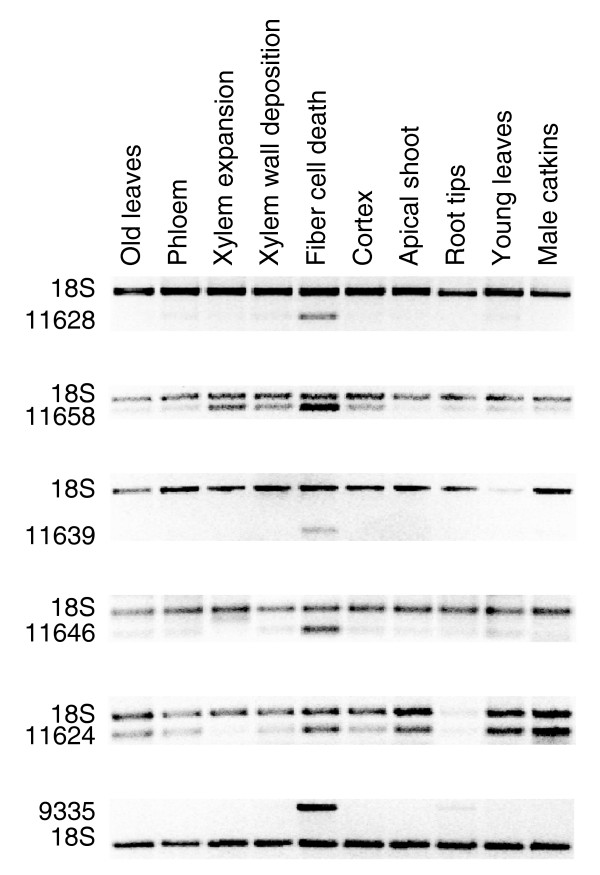
RT-PCR analysis of gene expression in different parts of a Populus tree. Expression of glycosyl hydrolase family 1 protein (POPLAR.11628), proline-rich protein (POPLAR.11658), oligopeptide transporter (POPLAR.11639), an expressed protein (POPLAR.11646), an F-box protein (POPLAR.11624) and a protease inhibitor/seed storage/lipid transfer protein (POPLAR.9335) is shown in relation to 18S DNA expression. Sampling of the different tissue types is described in Materials and methods.